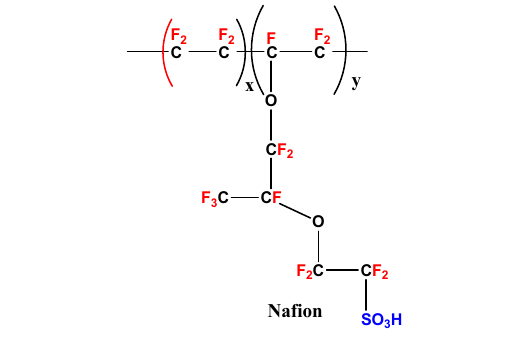
Figure 2. Chemical structure of Nafion ® .